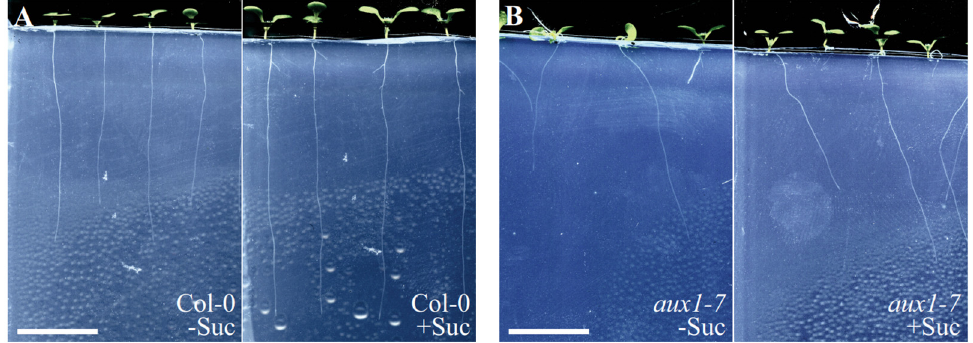
Figure 2. Representative images of seven DAG ( A ) Col-0 and ( B ) aux1-7 seedlings grown in agar that had been unsupplemented or supplemented with sucrose. Scale bar = 10 mm.